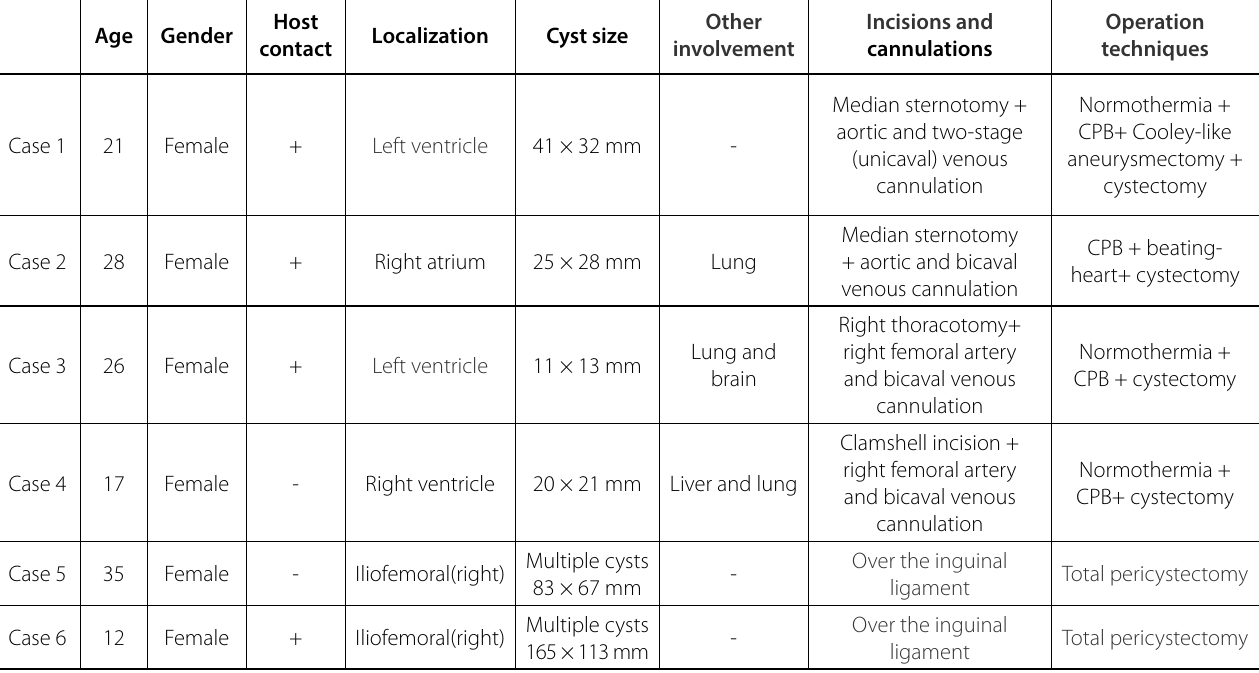
Table1 . Demographic data, host contact, involvement and surgery